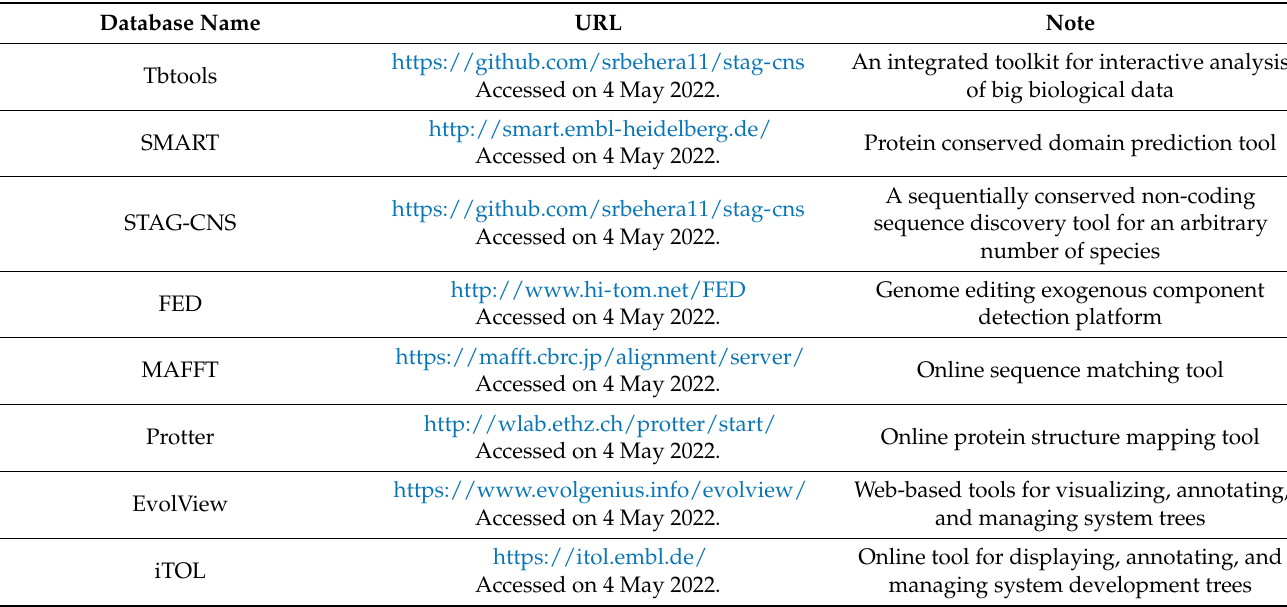
Table 4. Bioinformatics tools and websites that can be used in plant research.